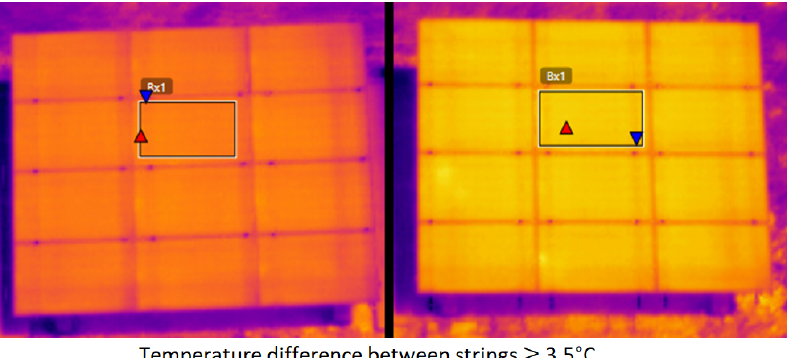
Figure 10. IR images analyzed for case 39. String 2 ( left ) and string 6 ( right ). In this one, it can be seen that string 6 had a higher temperature than the control PV array (string 2) due to the open circuit.